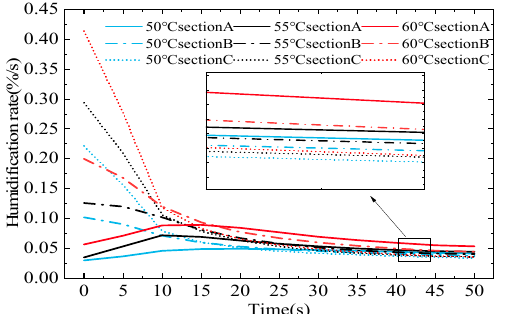
Figure 11. The effect of different temperatures on the humidification rate.